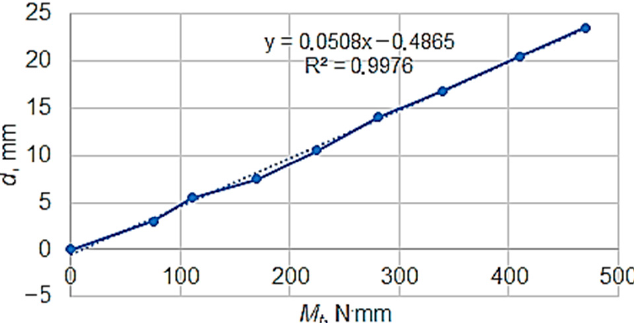
Figure 4. Calibration diagram for the indication d of the pressure measuring apparatus depending on the torsion moment M t .